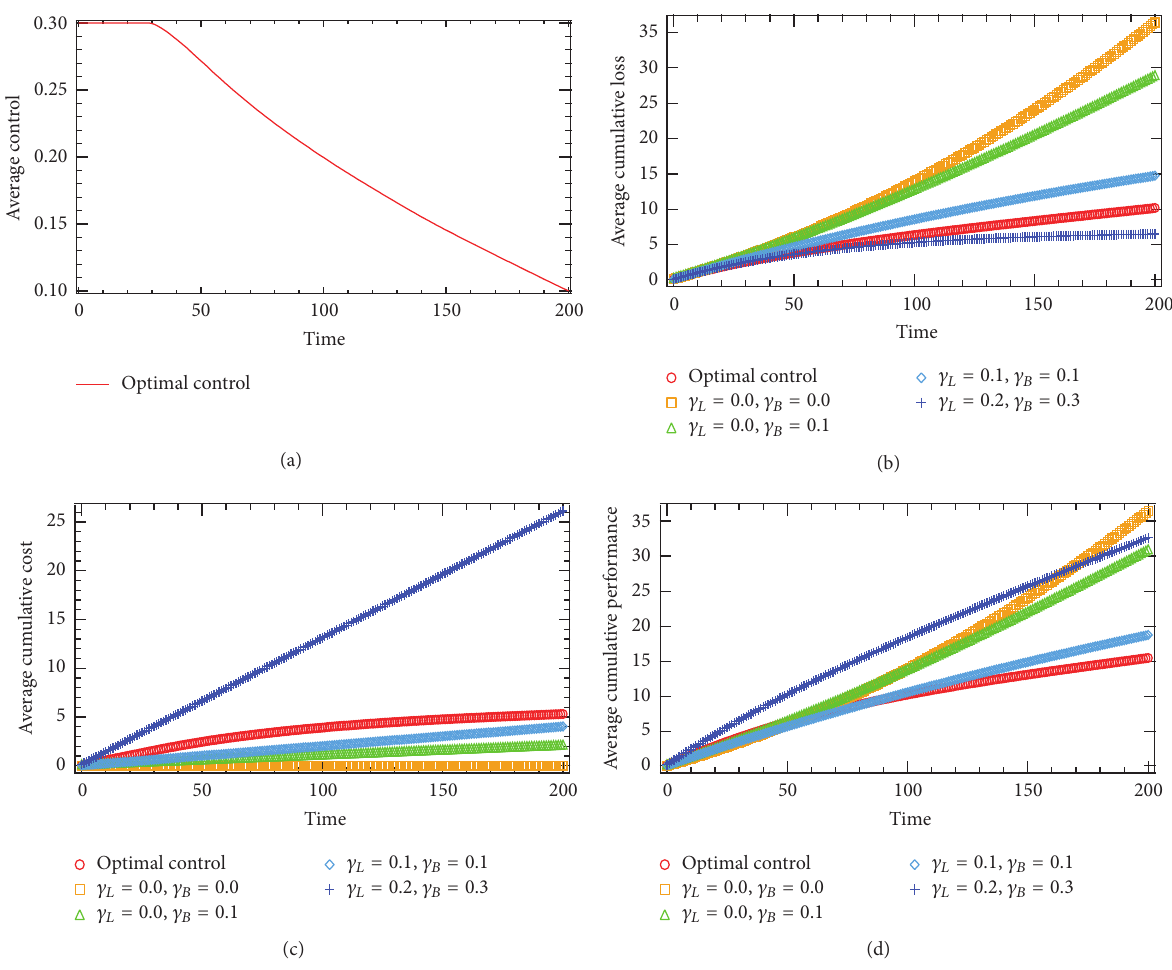
Figure 4: (a) The AC functions, (b) the ACL functions, (c) the ACC functions, and (d) the ACP functions for the optimal dynamic control strategies in Example